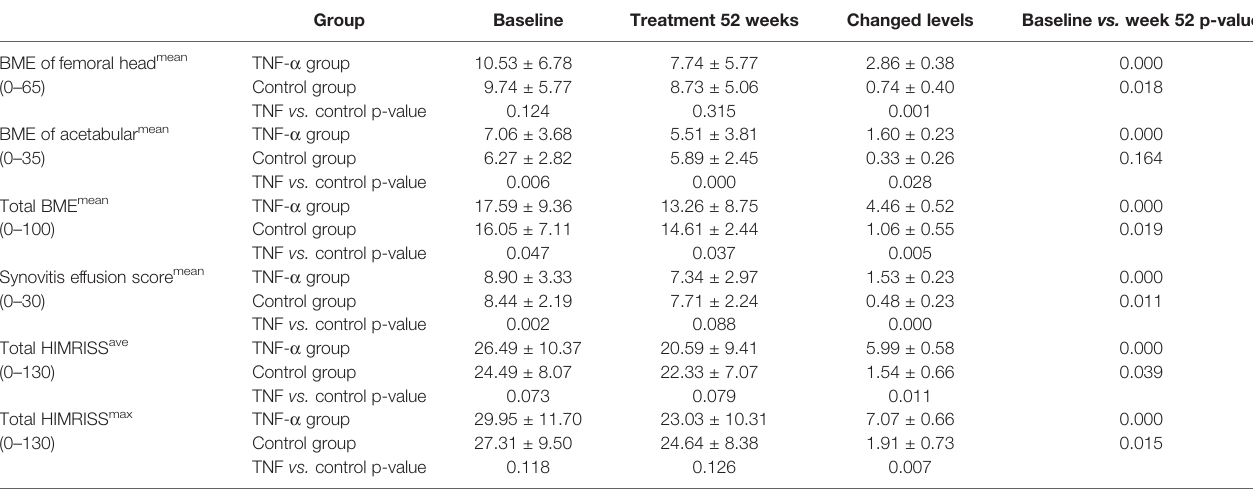
TABLE 2 | HIMRISS values from baseline to 52 weeks in the biological group and non-biological group. Group Baseline Treatment 52 weeks Changed levels